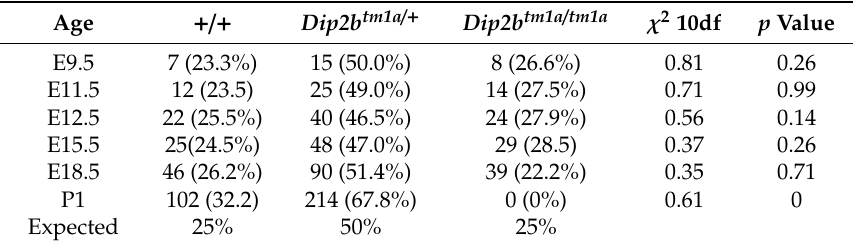
Table 1. Survival of Dip2b tm1a / tm1a